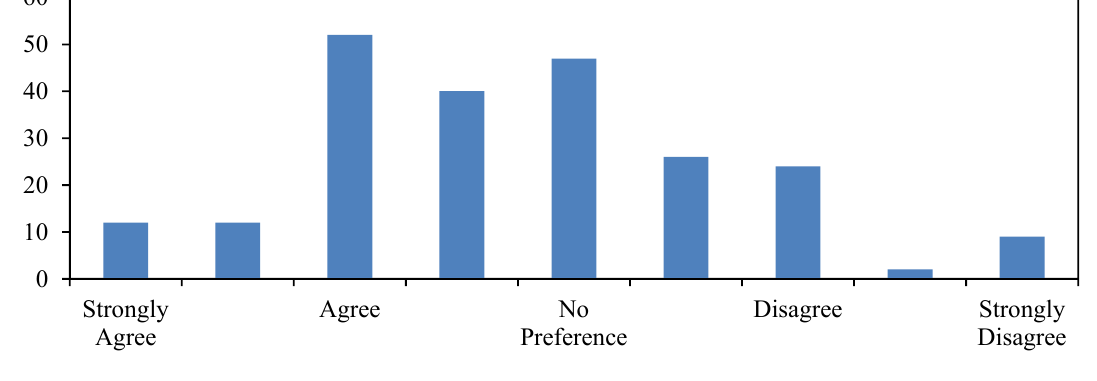
Figure 11. Graph of responses to the statement “I would trust a computer to prioritize data for transmission”.